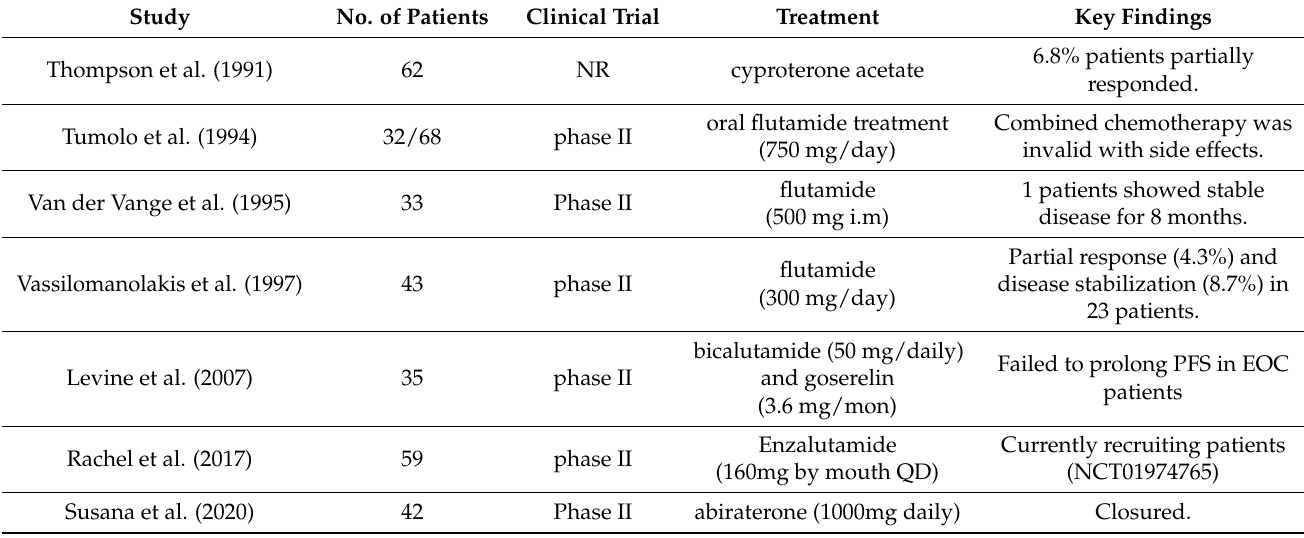
Table 1. Clinical trials of Androgen/ androgen receptor inhibitors in the treatment of ovarian cancer patients. Study No. of Patients Clinical Trial Treatment Key Findings